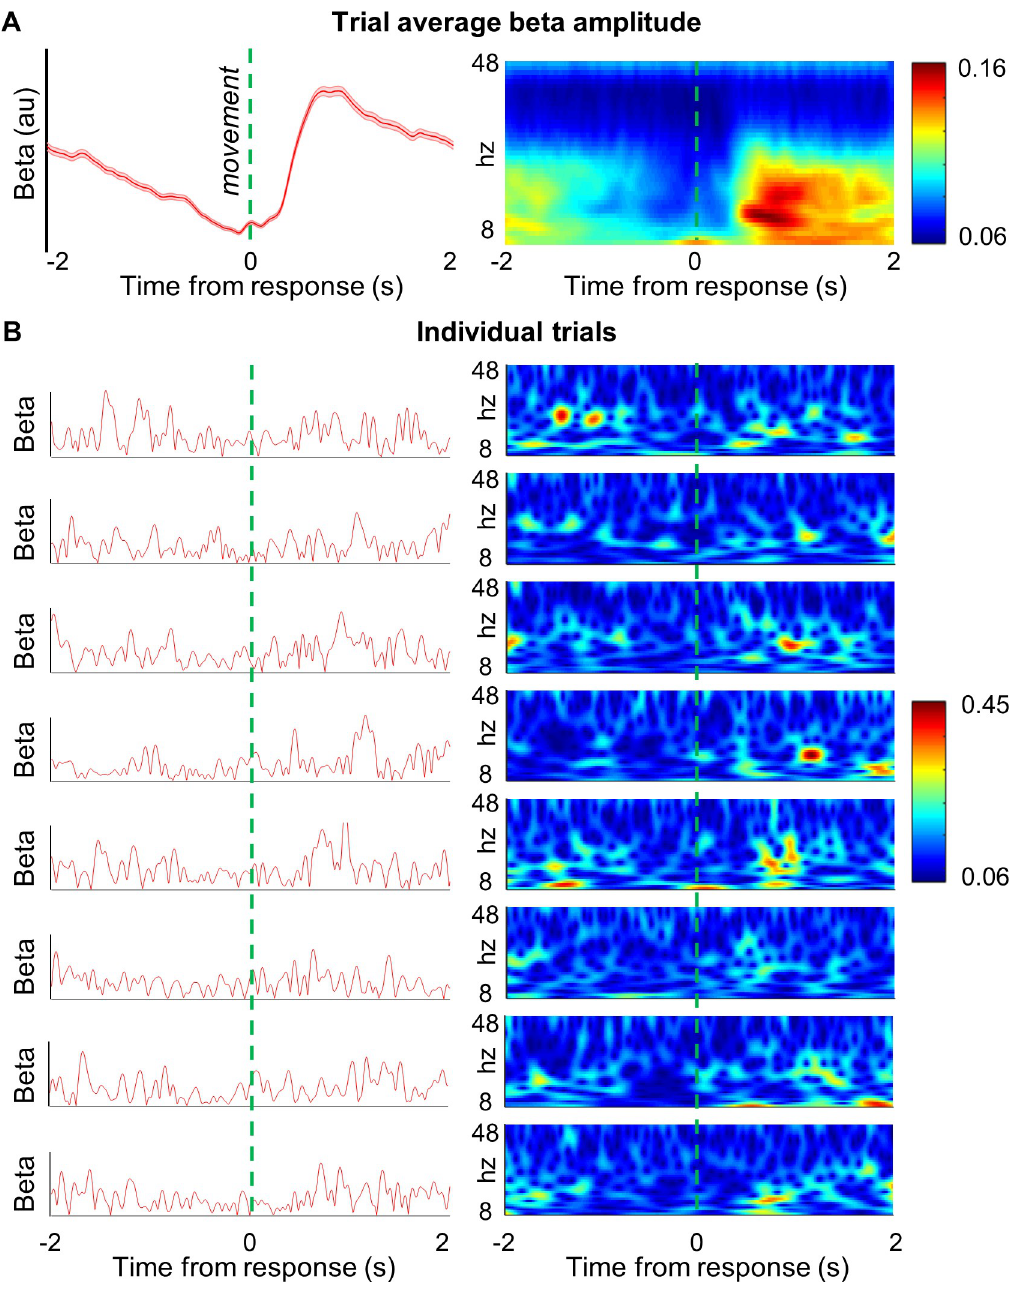
Fig 2. Single trial beta events do not match the dynamics of trial-averaged beta activity. (A) Time series of trial-averaged contralateral M1 beta amplitude (13–30 Hz; subject 2; block 1; mean ± SEM 535 trials; left panel). This shows classical ERD and ERS in the pre- and post-movement periods, respectively. Trial-average time-frequency amplitude spectrogram (same subject; wavelet decomposition; see Materials and methods; right panel) showing a reduction in spectral activity specific to the beta band in the period prior to movement, followed by an increase following movement. (B) Individual trial data from the same subject (no. 2; run 3; trials 250–258) as the beta amplitude envelope (red; left panels) and as time-frequency amplitude spectrograms (right panels). At the single trial level, beta amplitude does not closely resemble the trial average but appears highly dynamic with short lasting bursts, which are more common around the time of the average ERS. The underlying data can be found in the post-processed files (Subj2Run3.mat) at https://osf.io/eu6nx/. ERD, event-related desynchronisation; ERS, event-related